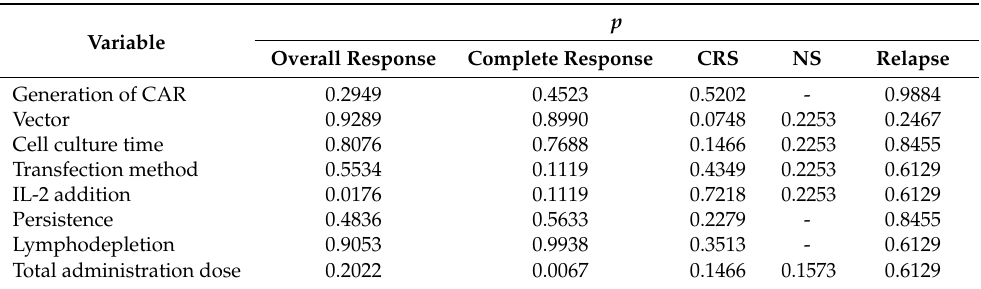
Figure 5. The forest plots of meta-regression analysis: ( a ) Forest plot for ORR and CI of cell culture with IL-2 addition and cell culture without IL-2 addition of each study and the overall; ( b ) Forest plot for CRR and CI of the total administration dose more than 10 8 cells and less than 10 8 cells of each study and the overall. Table 3. The result of meta-regression analysis about the association between the characteristic of cohorts and the difference rates included in this